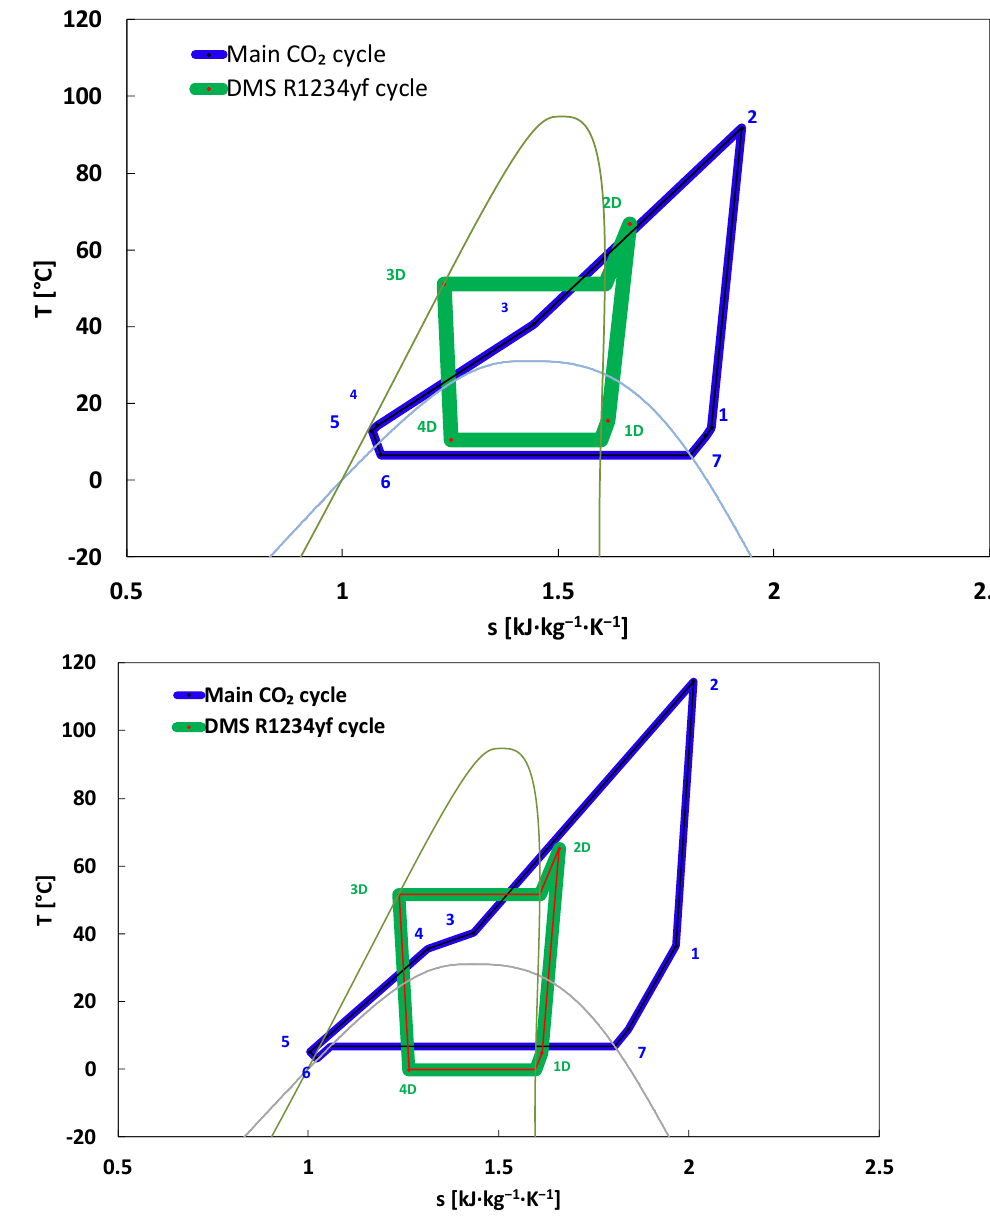
Figure 5. Thermodynamic diagrams of auxiliary cycle and CO 2 cycle for 2 DMS configurations: ( Up ) Configuration C. ( Down ) Configuration E.